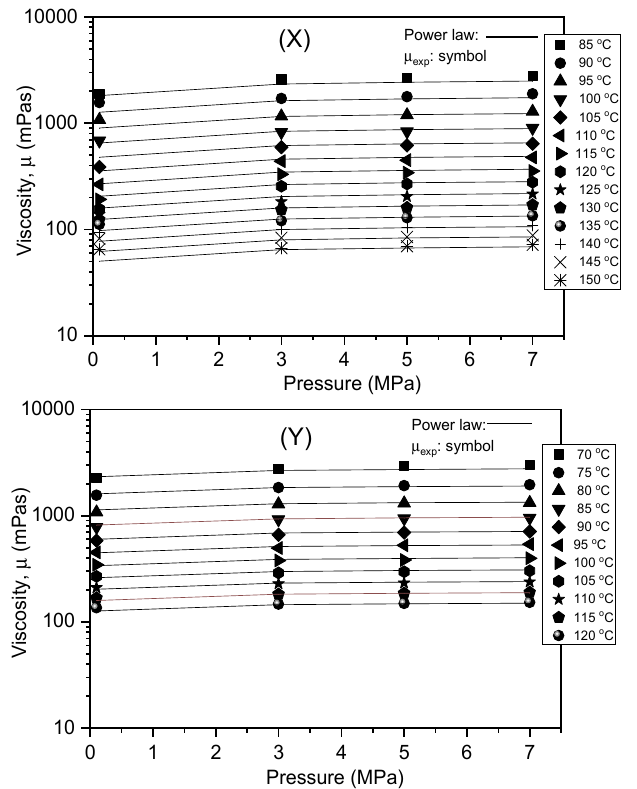
Figure 4. Experimental and calculated viscosities using Equation (1).